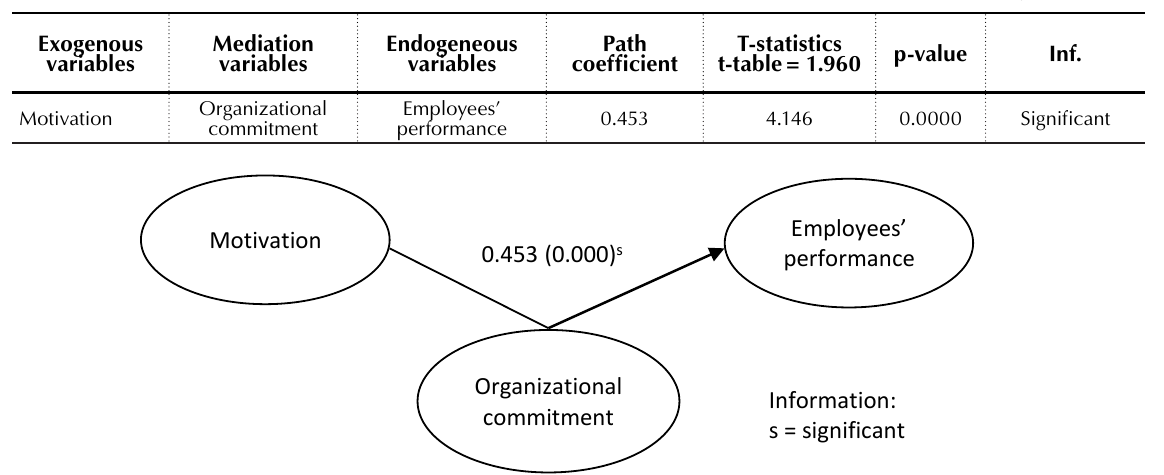
Table 2. Results of path coefficient and indirect effect hypothesis test